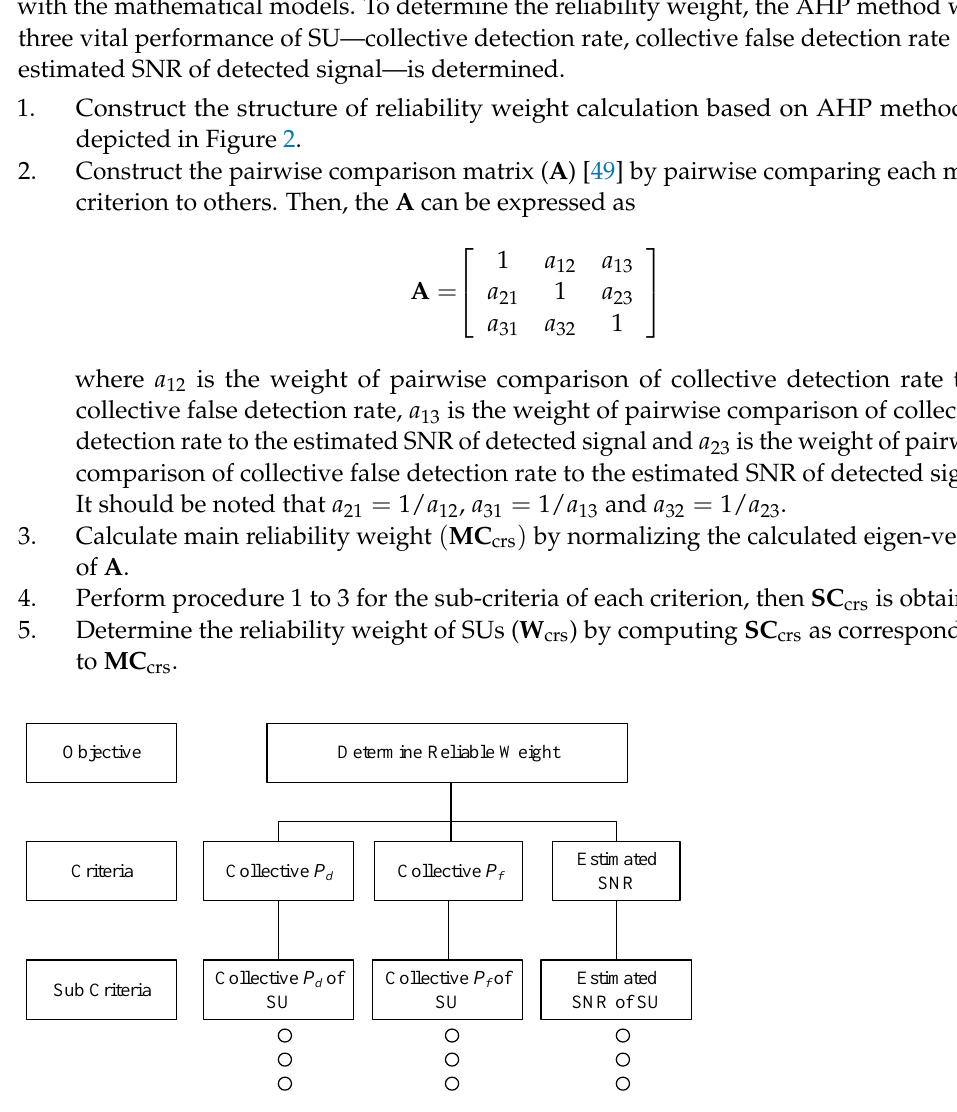
Figure 2. Structure of objective, criteria and